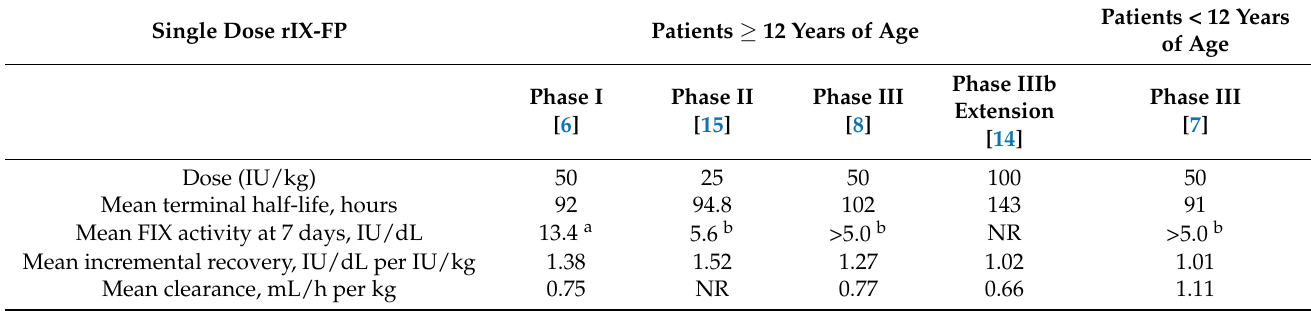
Table 1. Pharmacokinetics of rIX-FP in PROLONG-9FP